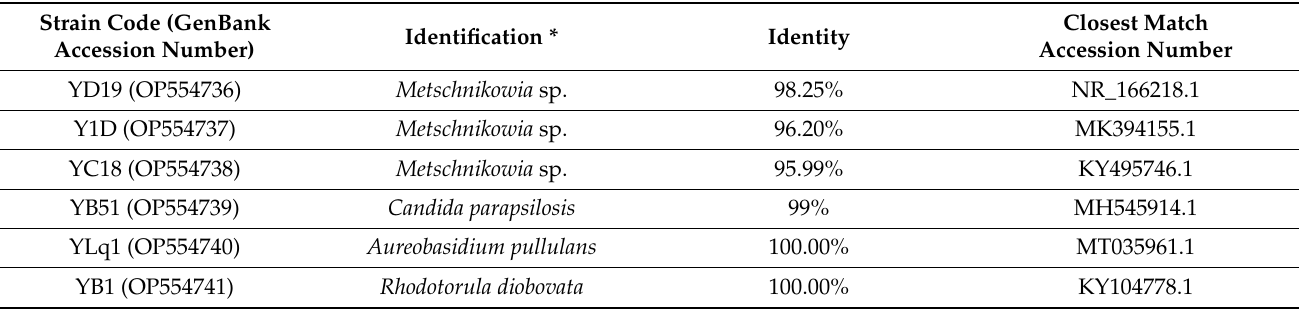
Table 2. Yeast isolates identified from Rhizostoma pulmo jellyfish samples. Yeast strains were identified according to their similarity to ITS1-5.8S-ITS2 region sequences in the GenBank nucleotide sequence database. The strains and the nucleotide sequence of the ITS1-5.8S-ITS2 region were deposited in the NCBI database; the corresponding accession numbers are